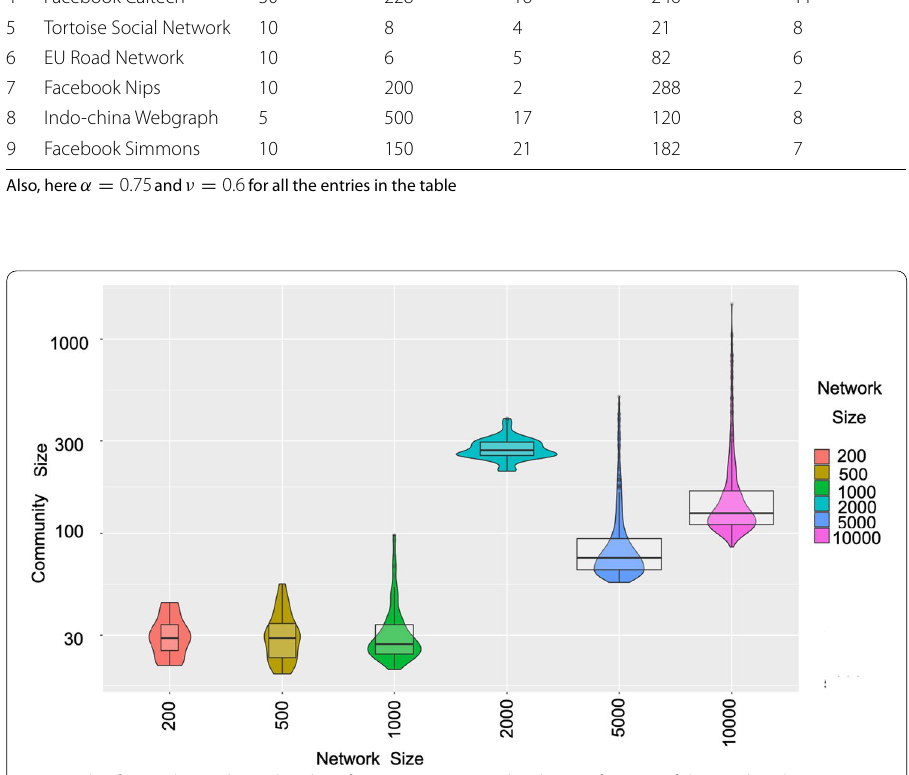
Fig. 8 This figure shows the violin plot of a community size distribution for 10% of the seed nodes on networks from Table 4. The value of the parameters are δ = 0.3,0.55,0.60,0.65,0.70,0.75,0.80,0.85,0.90,0.95 , α = 1 and ν =